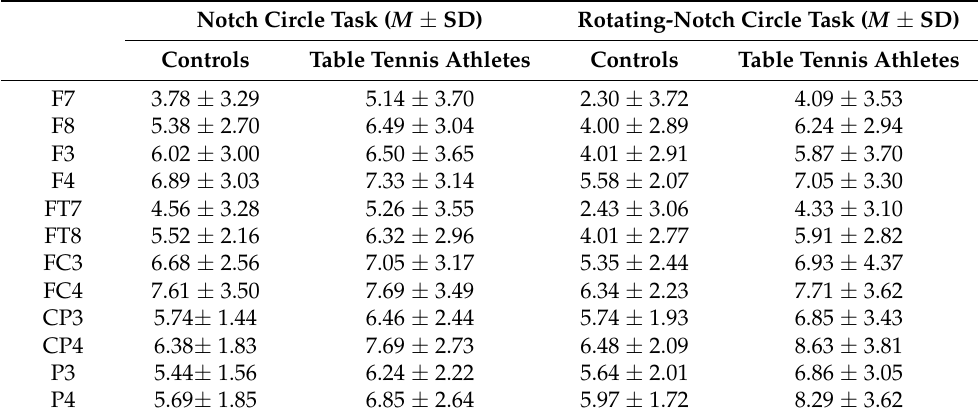
Table 3. Grand-average peak amplitude ( µ V) of the P3 component for correct responses across multiple electrode sites in the control and table tennis groups.